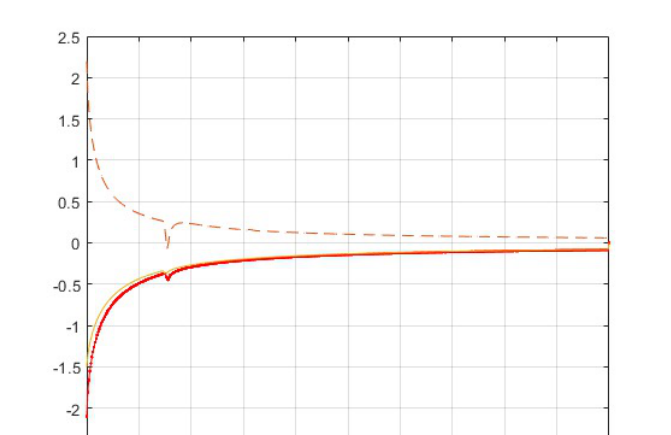
Figure 8. Leader–follower multi-agent system’s error state ω j ( τ ) .